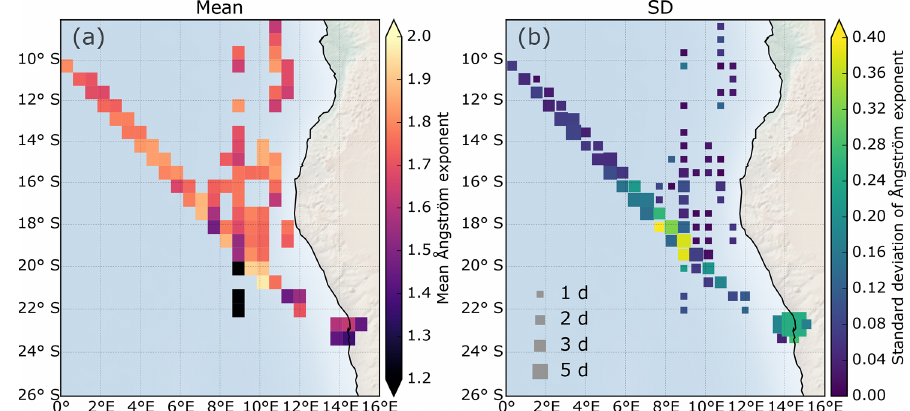
Figure 8. Map of mean AE 470 / 865 derived from AOD spectra of aerosols above clouds, calculated from (a) two wavelengths (470 / 865nm) and (b) the standard deviation of the AE 470 / 865 , where the size of the squares represents the number of sampling days (abbreviated as “d”) used to build the statistics within each gridded bin, nearly the same number as shown in Fig.